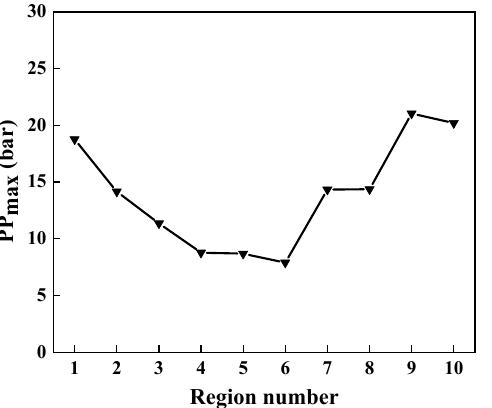
Figure 5. Comparison of PPmax in all ten regions under B20 working conditions.